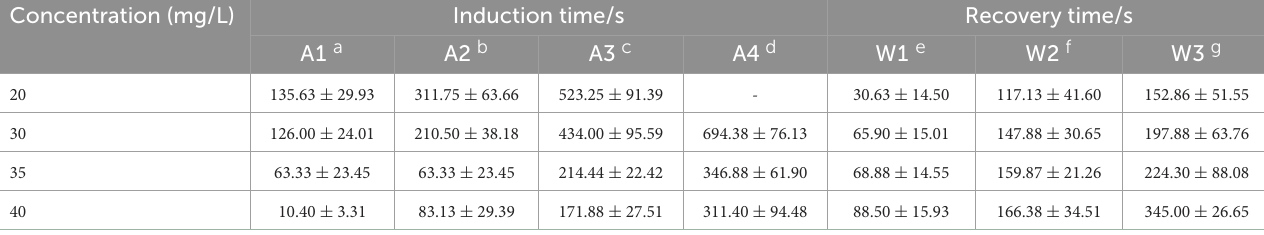
TABLE 3 Induction and recovery time in carp at different eugenol concentrations a . Concentration (mg/L)